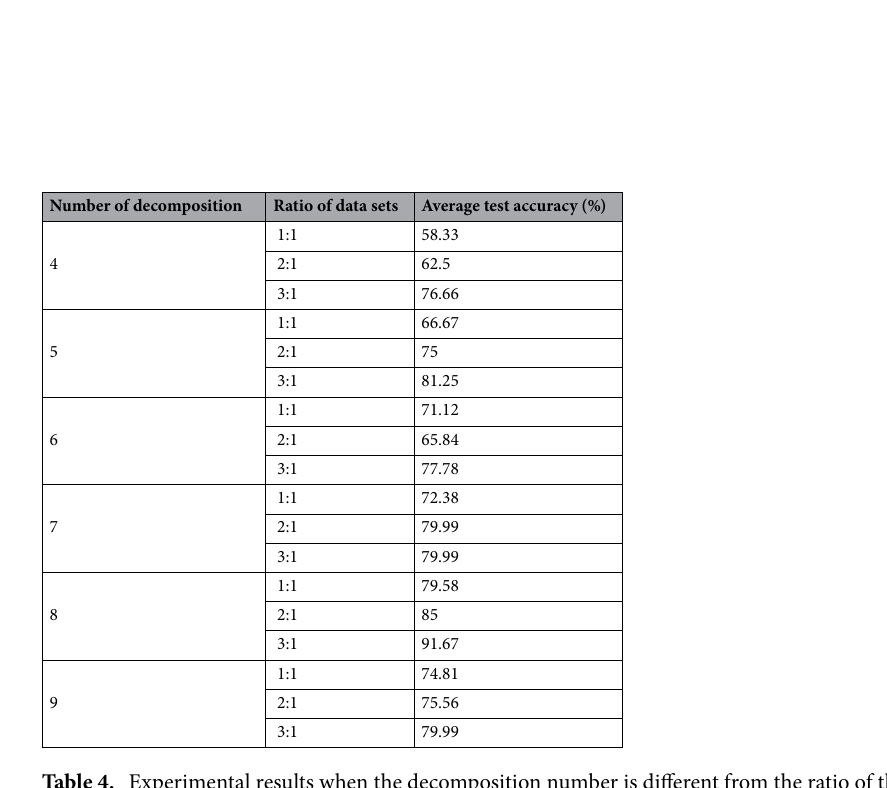
Table 4. Experimental results when the decomposition number is different from the ratio of the data set.